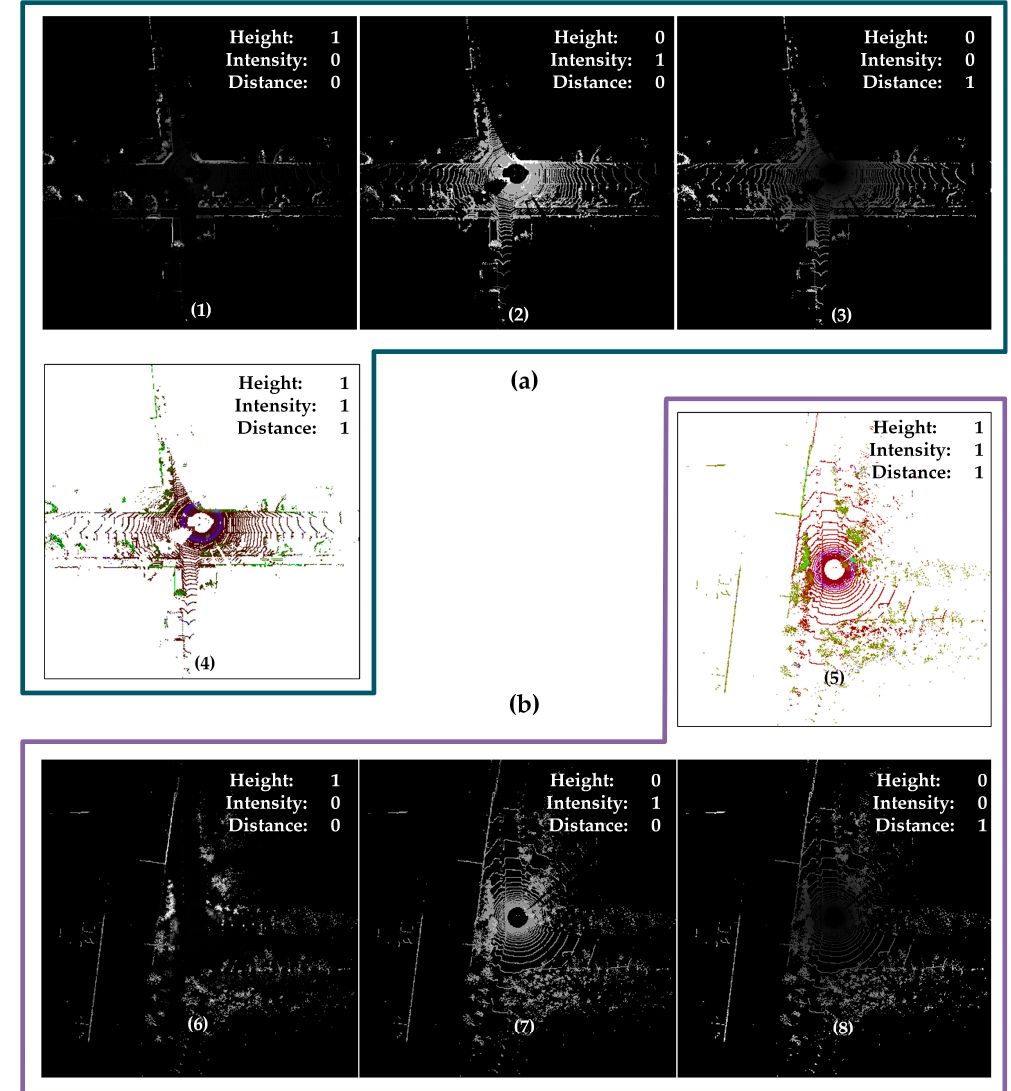
Figure 10. Illustration of CMCD and simple bird’s eye view projection: ( a ) The CMCD projection of frame 2582 on KITTI-05 (as shown in (4)) and the corresponding single-channel projection of height, intensity, and distance (as shown in (1), (2) and (3), respectively); ( b ) The CMCD projection of frame 3715 of jlu02 (as shown in (5)) and the corresponding single-channel projection of height, intensity, and distance (as shown in (6), (7) and (8), respectively). In the legend, “Height: 1; Intensity: 0; Distance: 0,” indicates that the image is projected according to the height